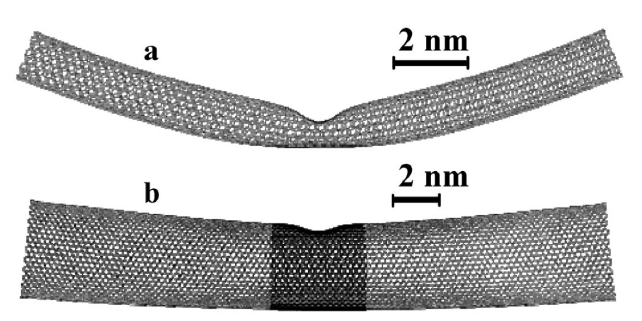
Figure 11. Predicted shape of SWNTs just after buckling, based on MD simulations for ( a ) a 15.7-nm-long (10, 10) SWNT at the bending angle θ = 43 ◦ ; and ( b ) a 23.6-nm-long (30, 30) SWNT at θ = 23 ◦ . Note the difference in scale. Reprinted from Reference [68].